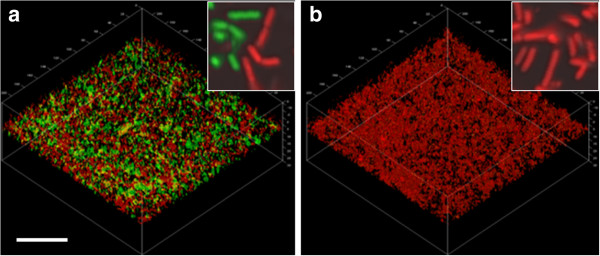
Proteolytic activities of Lactobacillus fermentum biofilm populations in the presence or absence of MUC5B mucins. CSLM images showing biofilm cells growing in (a) the presence of a MUC5B environment or (b) a nutrient broth environment. Proteolytic activity was visualized by incubation with a FITC-conjugated casein substrate (green) for 1 hour. Cells were then counterstained using Syto 24 (red). The bar represents 20 μm and the inserts show four-fold enlargements of the main micrographs.